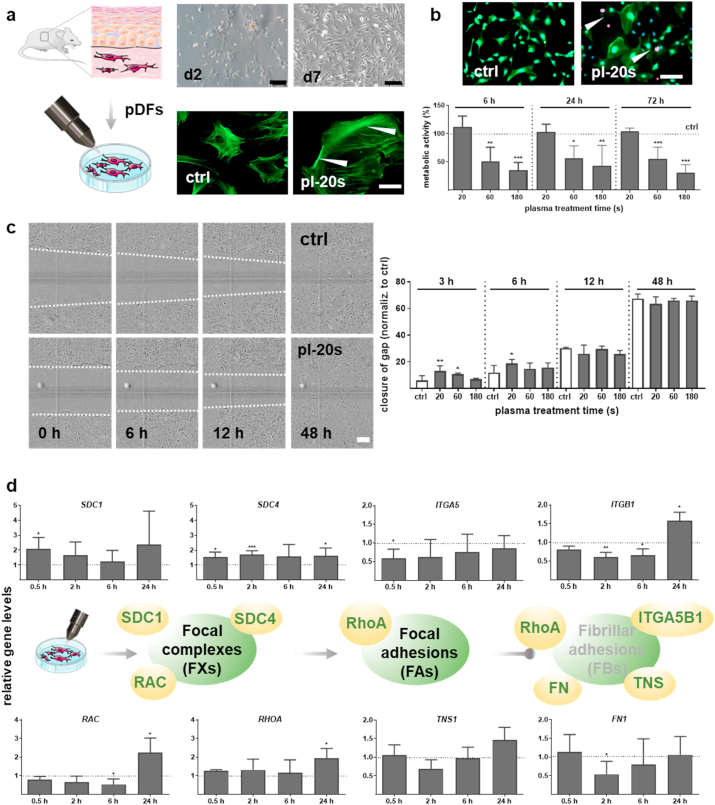
Gas plasma affected the viability, metabolic activity, and motility of dermal fibroblasts and regulated the molecular machinery of integrin adhesions. (a) Experimental workflow. Primary dermal fibroblasts (pFDs) were isolated from the skin of SKH1 mice and cultivated over ten days in fibroblast medium. pDFs were incubated with medium exposed to gas plasma for 20 s, 60 s, or 180 s, or were left untreated (ctrl), and analyzed by several down-stream assays. Representative phase-contrast images of the progression of pDFs after isolation from the skin of SKH1 mice on d2 and d7. Scale bars are 100 μm. F-actin stress fibers were visualized using FITC-phalloidin fluorescent probe (green); arrowheads show cell border staining in untreated (ctrl) and gas plasma-treated cells (pl-20 s). Scale bar is 50 μm (b) Live/dead assay measured at 6 h after gas plasma treatment, demonstrating mainly viable cells (green, calcein-positive) along with a few dead cells (red, propidium iodide-positive, pl-20 s) in comparison to control (ctrl). Scale bar is 50 μm. Quantification of metabolic activity of pDFs after 6 h, 24 h, and 72 h following gas plasma treatment. (c) Representative images showing migration of pDFs in untreated and gas plasma-treated (pl-20 s) pDFs. Scale bar is 200 μm. Quantification of wound closure and migratory behavior of pDFs up to 48 h after gas plasma treatment measured by wound healing scratch assay. (d) pDFs were harvested and lysed at 0.5 h, 2 h, 6 h, and 24 h after gas plasma treatment (20 s). qPCR of syndecans (SDC1/4), integrins (ITGA5, ITGB1), small GTP binding proteins (RAC, RHOA), tensin 1 (TNS), and fibronectin 1 (FN1) was perfomed in pDFs. Statistical analysis was done by unpaired two-tailed Student's t-test with significances of *p < 0.05, **p < 0.01, and ***p < 0.001. (For interpretation of the references to color in this figure legend, the reader is referred to the Web version of this article.)